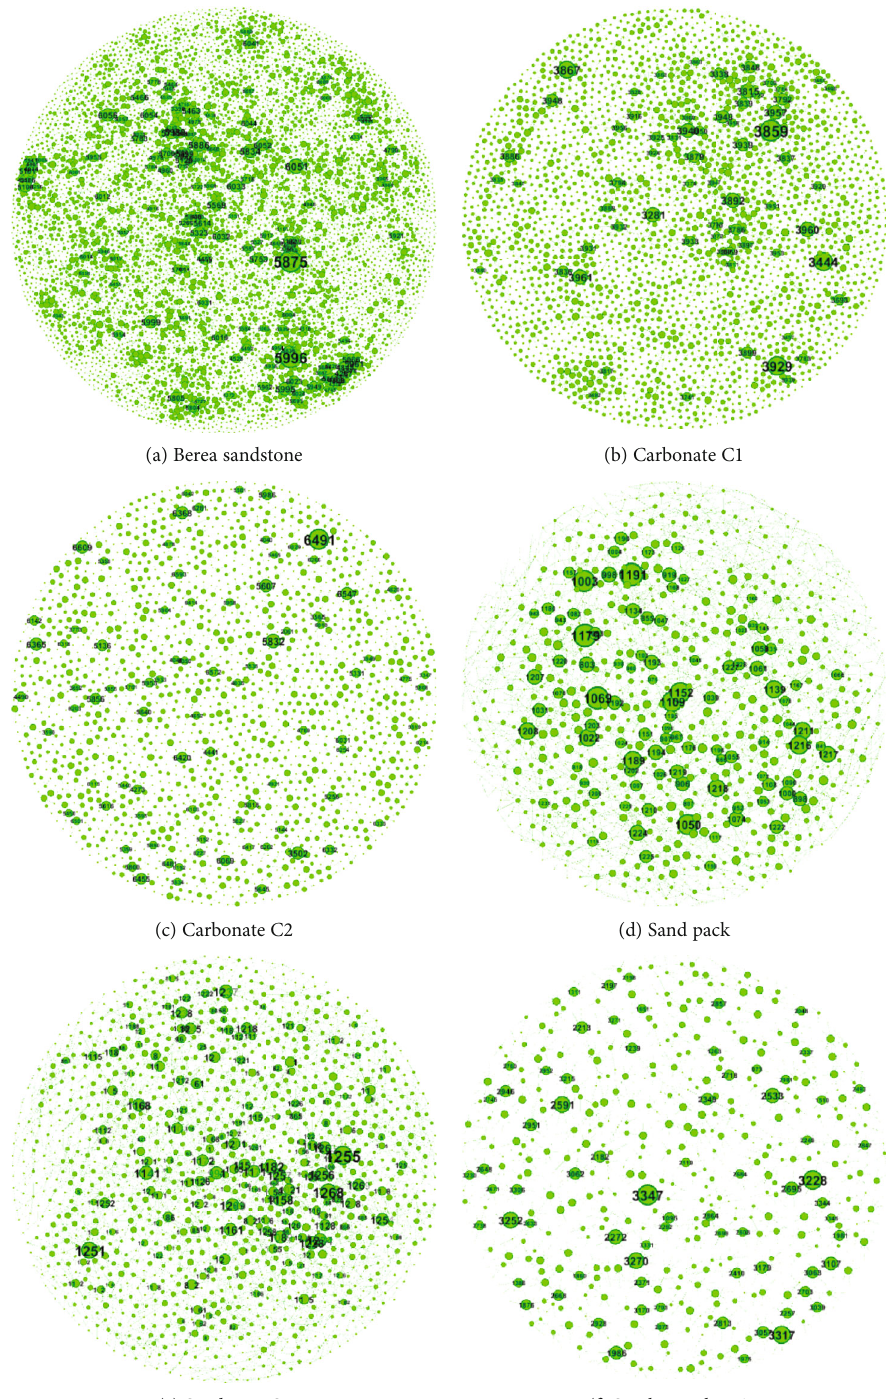
Figure 5: Centrality of rock